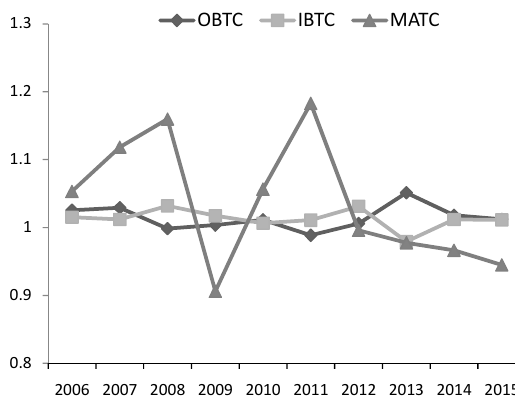
Figure 5. Annual MI, efficiency change (EC) and technical change (TC) index.